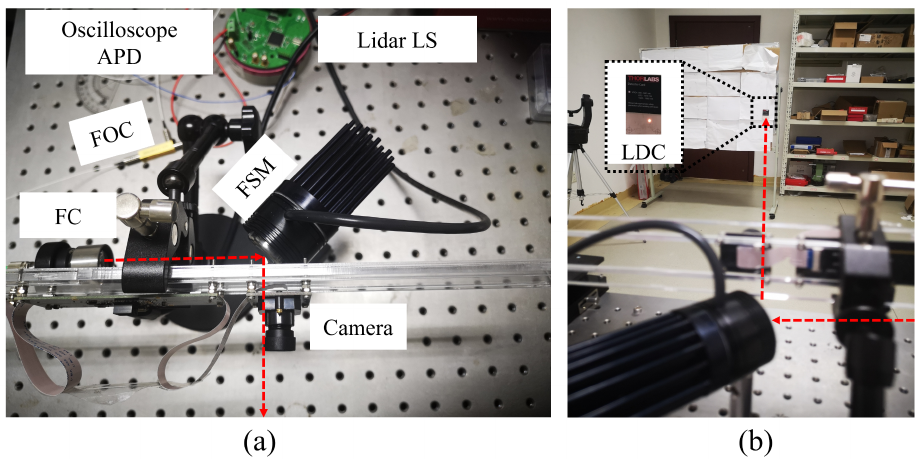
Figure 11. Calibration experiments of the LiDAR–camera system. ( a ) LiDAR–camera system. ( b ) Cal- ibration experiment.